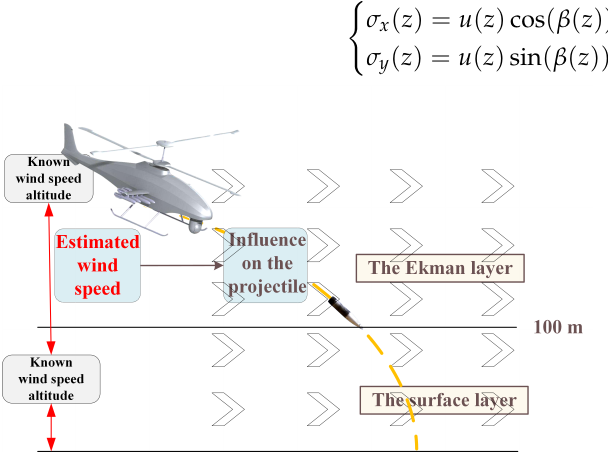
Figure 4. The schematic diagram of the wind disturbance